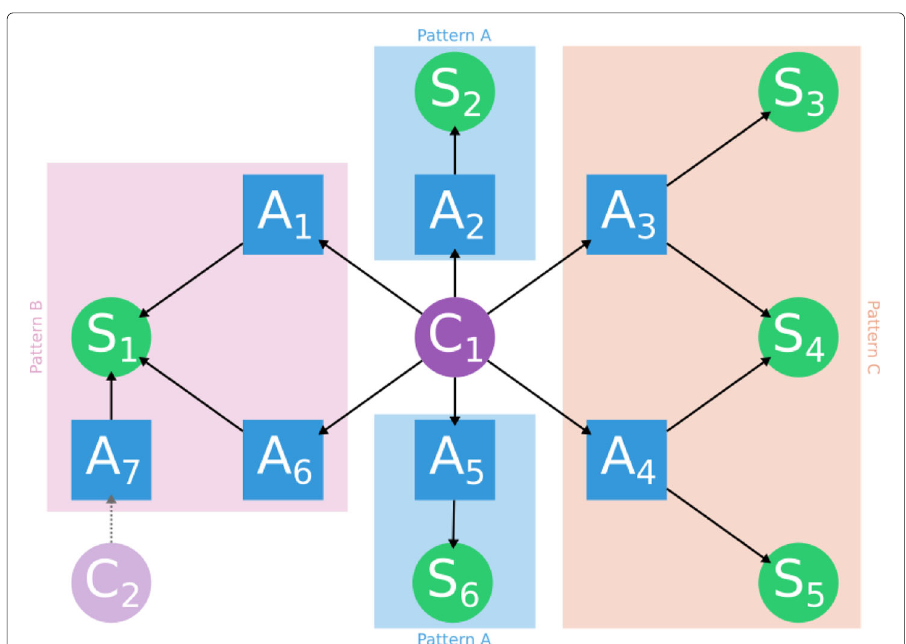
Fig. 3 Transaction Graph T1. The transaction graph is created by assigning vertices to every account and supplier companie found in the set of transactions. Edges are created when an account and a supplier company are found in the same